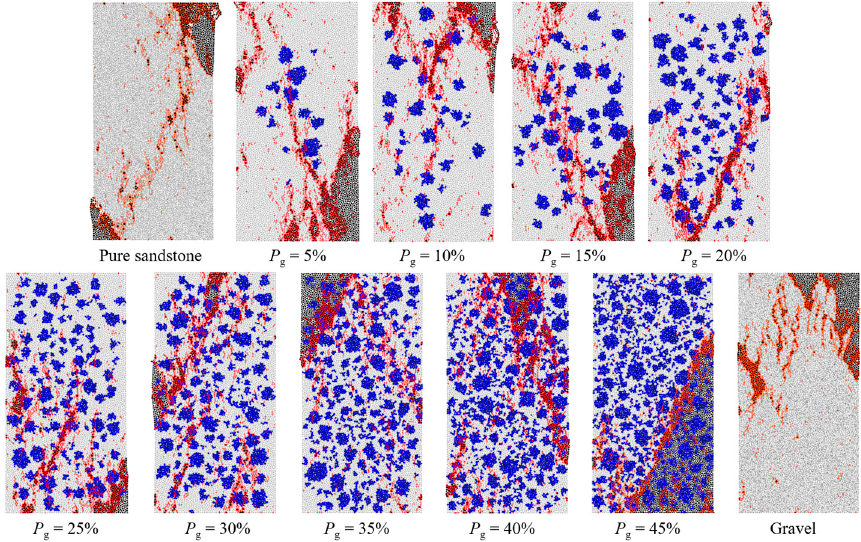
Figure 9. Failure results of the DEM rock samples after the simulated UCS tests.